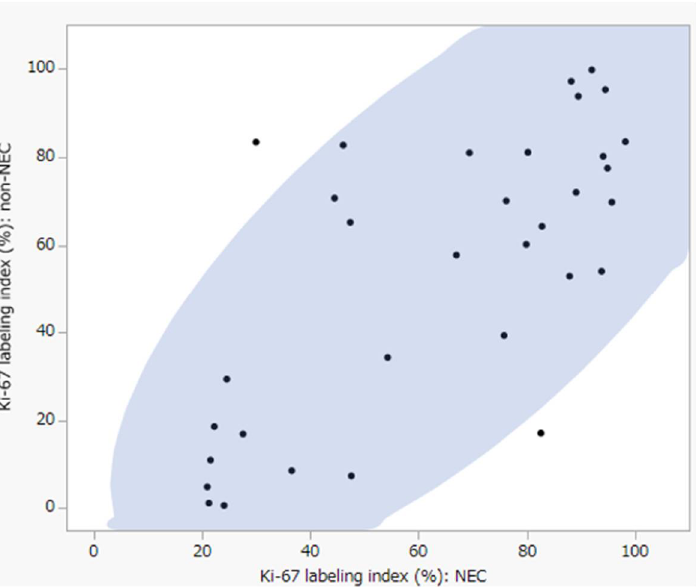
Figure 3. The plot of Ki-67 labeling index each of non-NEC and NEC component (vertical: non-NEC, horizontal: NEC). Non-NEC: 1–99%, NEC: 21–98%.